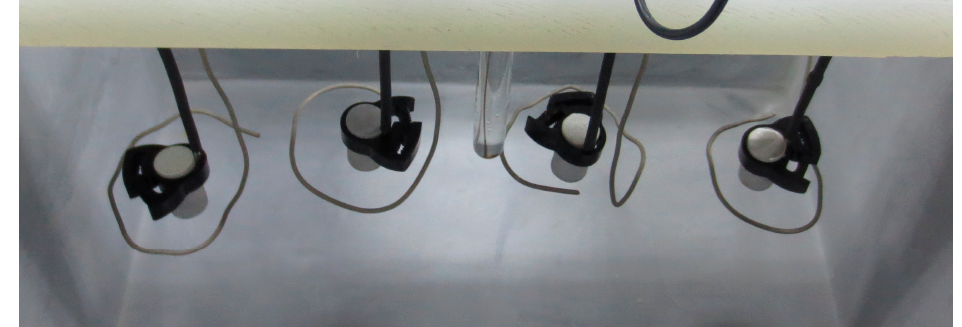
Figure 1. Photograph of the set of specimens before cathodic charging at − 1100 mV (Ag / AgCl /